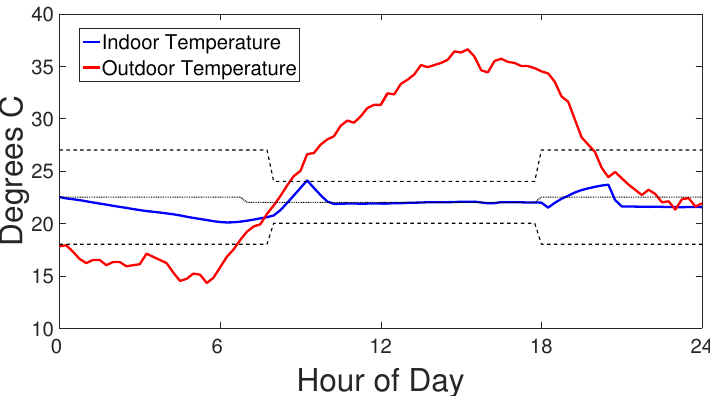
Figure 3. Time profiles of the building’s indoor and outdoor temperatures under the rules-based control scheme.